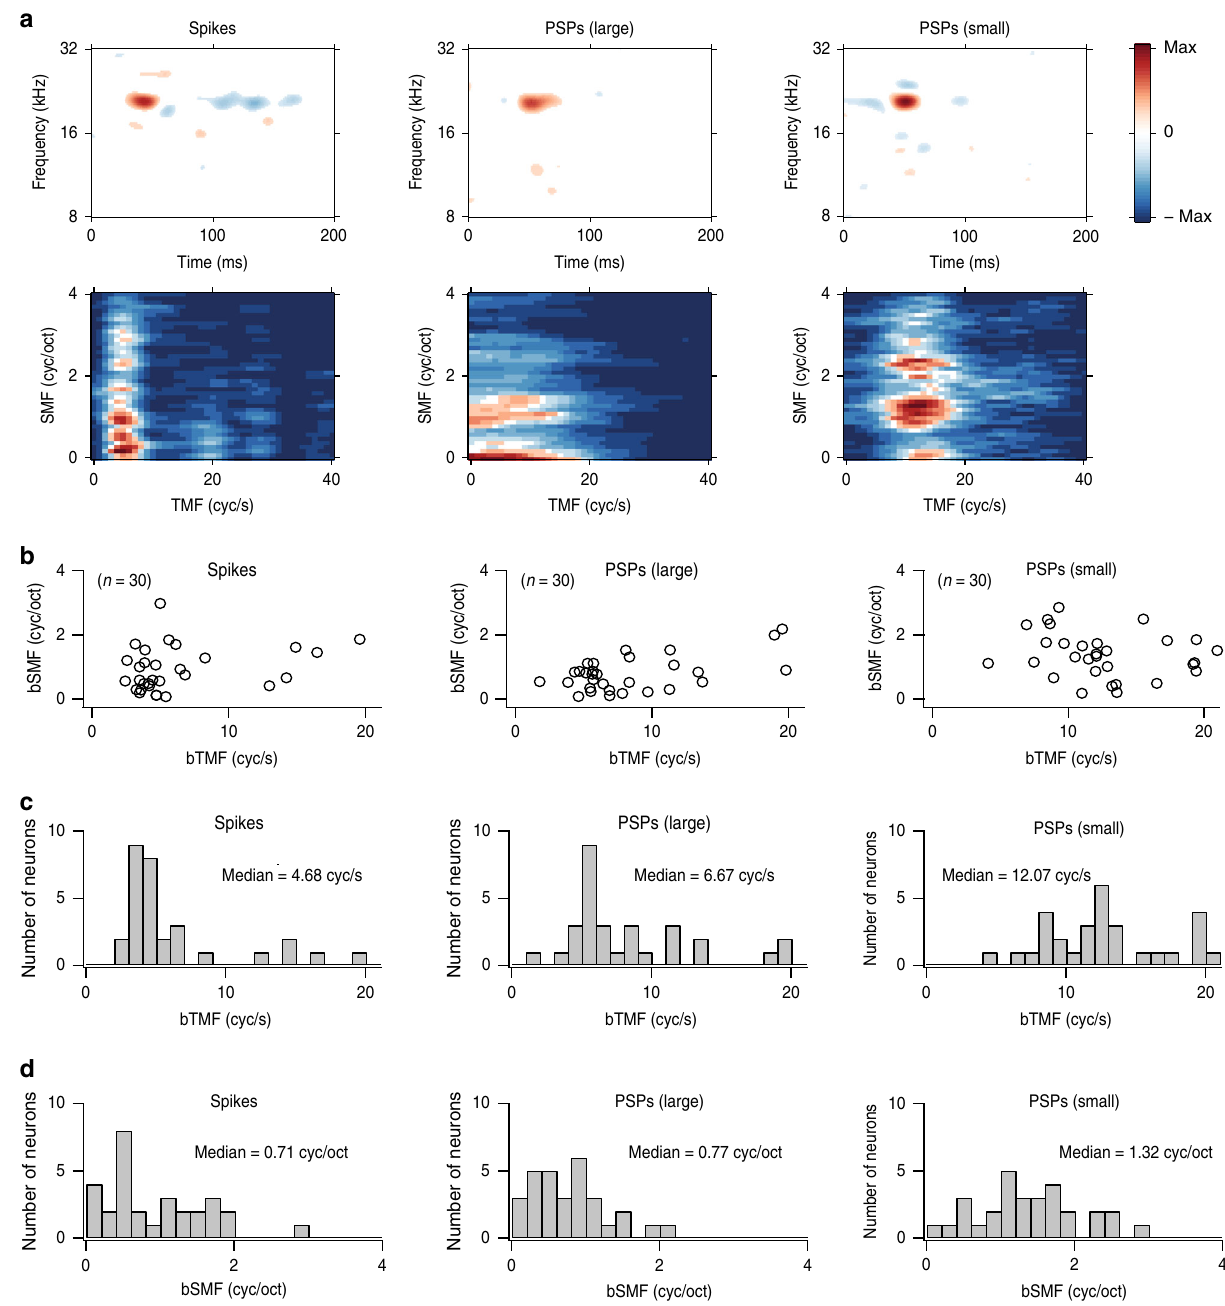
Fig. 4 Best modulation frequency. a An example of the modulation processing analysis. Top, STRFs ’ best frequency was ~20.5 kHz. STRFs were plotted on the same absolute scale. The number of peaks included in computing each STRF was 851 for spikes, 925 for large PSPs, and 1155 for small PSPs. Bottom, the corresponding RTFs are located at the bottom of each STRF. The spectral modulation preferences for the example neuron were 0.56 cyc/oct (spikes), 0.10 cyc/oct (large PSPs), and 1.33 cyc/oct (small PSPs), which also indicate distinct modulation preferences for spiking and subthreshold activity. b Plots of bSMFs versus bTMFs for spikes (left), large PSPs (middle), and small PSPs (right) from neurons ( n = 30/40) with signi fi cant STRF sub fi elds for spiking, large PSP, and small PSP events. There were weak or moderate correlations (spikes: Pearson ’ s r = 0.28, p = 0.13; large PSPs: Pearson ’ s r = 0.53, p = 0.003; small PSPs: Pearson ’ s r = − 0.19, p = 0.31). c Histograms of bTMFs for spikes (left), large PSPs (middle), and small PSPs (right). d Histograms of bSMFs for spikes (left), large PSPs (middle), and small PSPs understand how modulation information carried by synaptic and spike-based STRFs (Fig. 4a, top left) showed a signi fi cant high- spiking activity differs, and how it may be transformed by the energy sub fi eld (red) combined with a longer-latency suppression spike generation process. STRFs with signi fi cant sub fi elds (e.g., sub fi eld (blue). By contrast, the STRF for small PSPs showed a Fig. 2a; n = 30/40) were transformed into ripple transfer func- short as well as a long-latency suppression sub fi eld indicating tions (RTFs; see the “ Methods ” section) that re fl ect the preferred potential temporal modulation diversity (Fig. 4a, top right). These spectral and temporal modulations present in the stimuli. The STRF differences are re fl ected in RTF differences (Fig. 4a, bottom